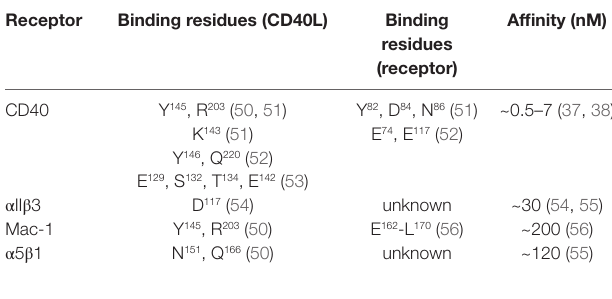
TABLe 1 | Binding properties of CD40L’s